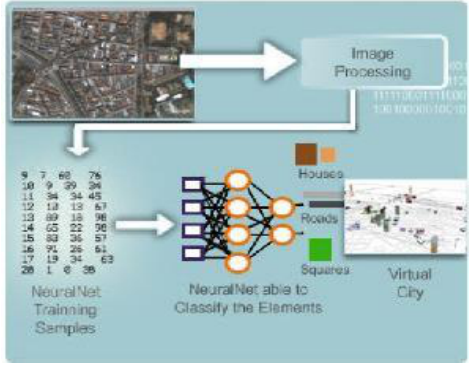
Fig. 16- Virtual 3-D City model generation by using ANN. (Source-Juliana and